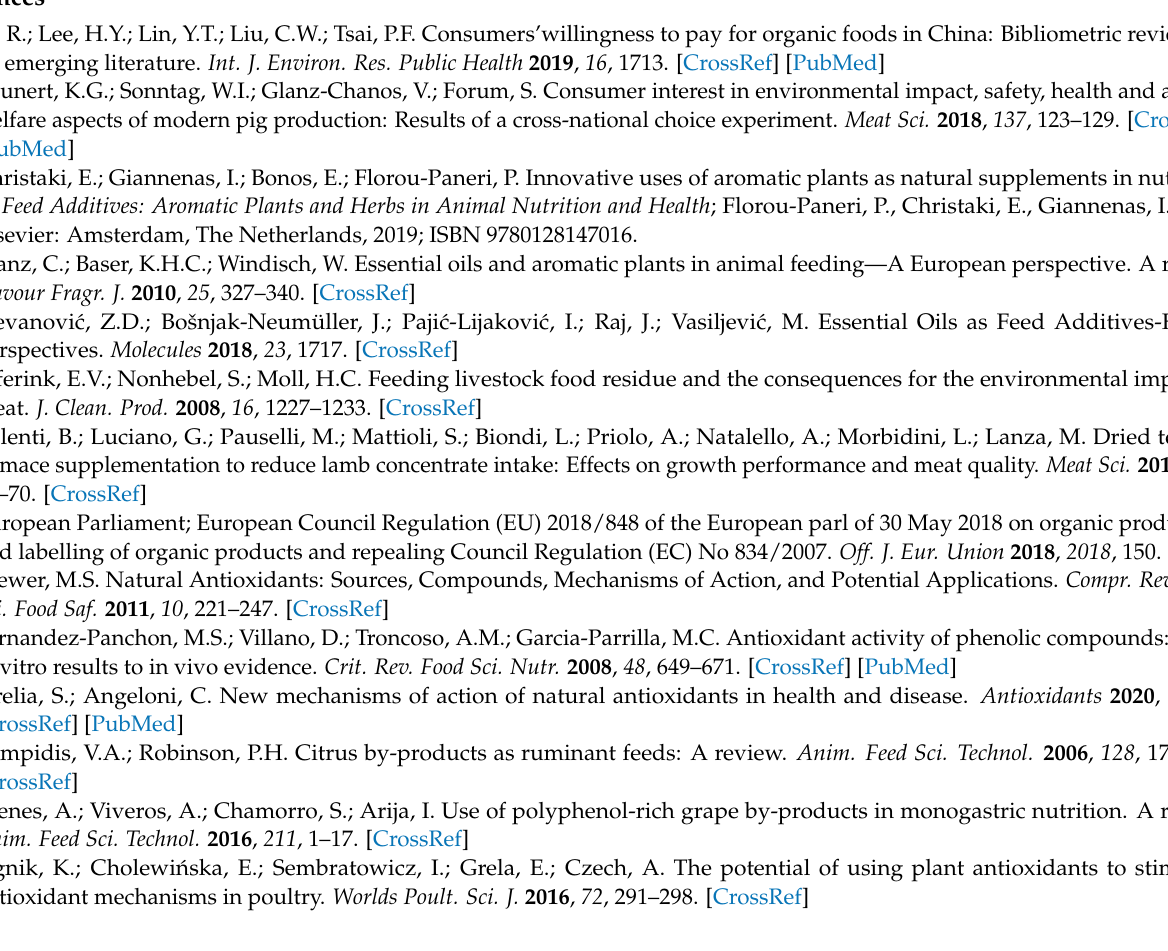
Table S2 Effects on quantitative and qualitative traits of lamb meat and cattle and sheep